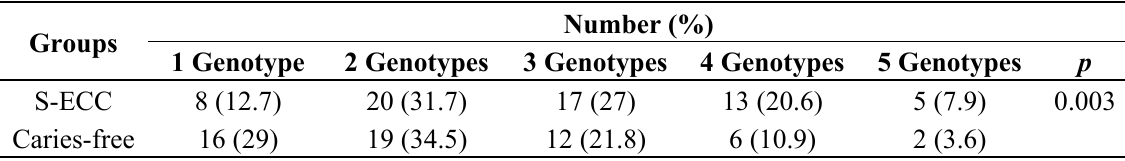
Table 2. The genotypes of S. mutans from children with S-ECC and CF children. From 1 to 5 genotypes were detected in both